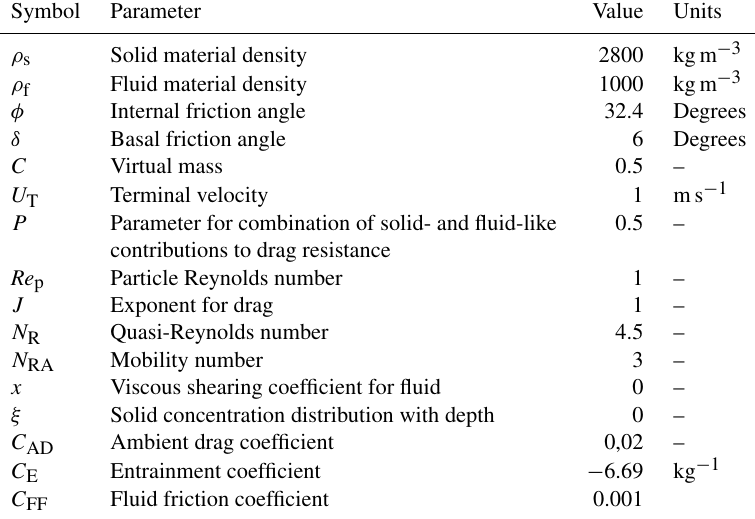
Table 2. Model parameters used in